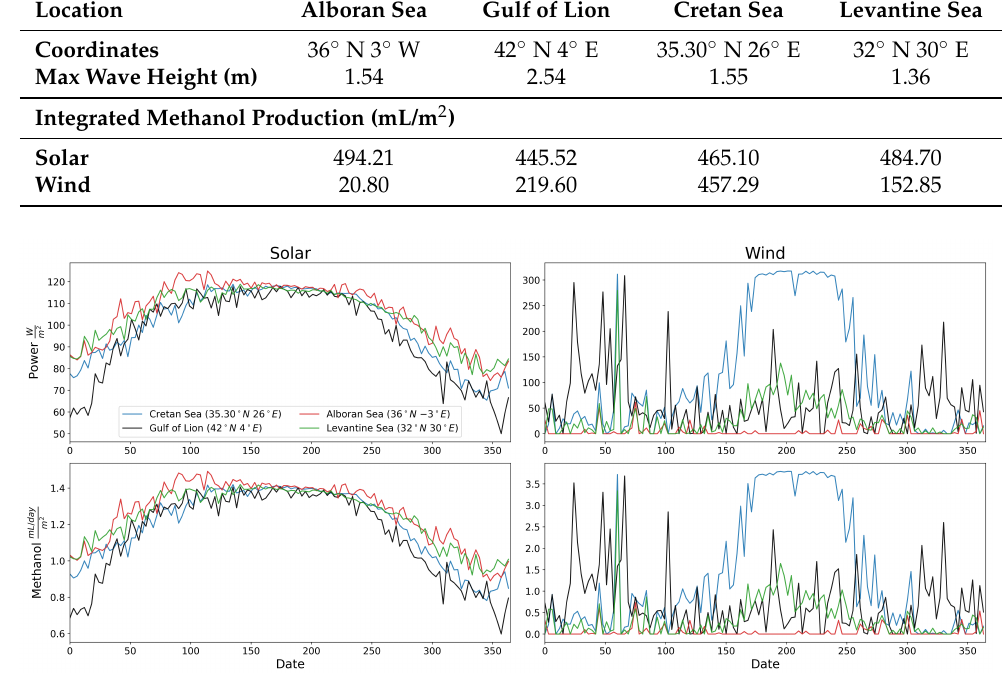
Figure 19. Ensemble time series for the point locations in Table 2. Solar panel and SWT-3.6-120 wind power generation are presented, as well as the corresponding methanol production from the two power resources. The solar panel power generation and methanol production time series are window averaged to make the temporal trends more visible, as production drops to zero every